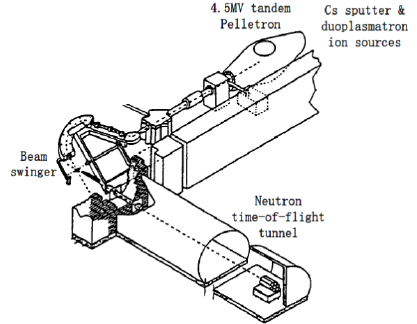
Figure 2. Beam swinger magnet diagram, Ed- wards Acceleration Laboratory.